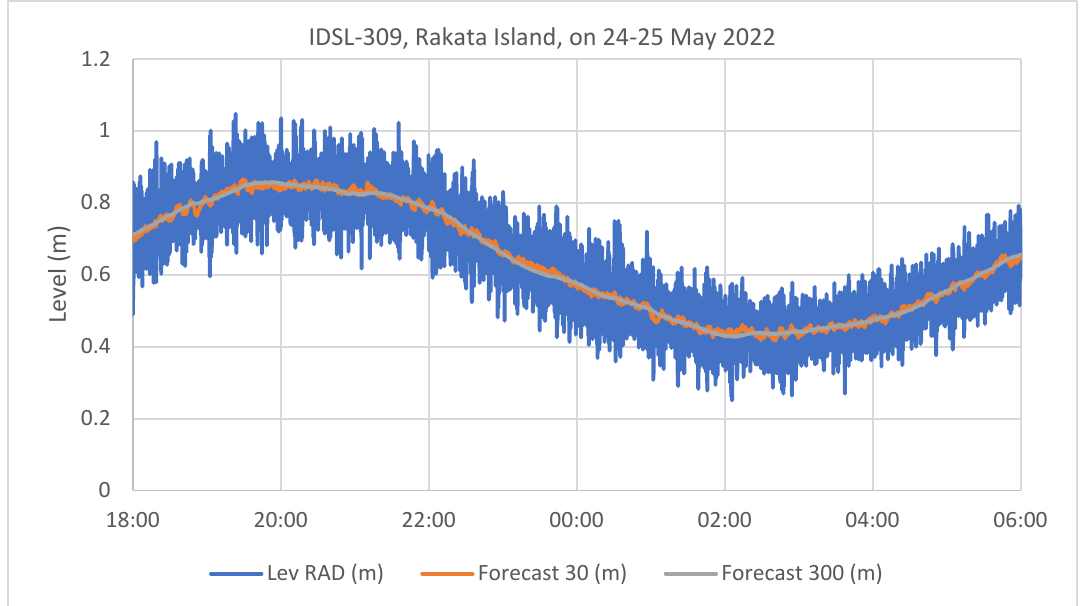
Figure 1. Sea level signals and computer parameters for a 6 h period between 24 May 2022 18:00 and 25 May 2022 06:00 on the IDSL-309 installed on Rakata Island, Indonesia.